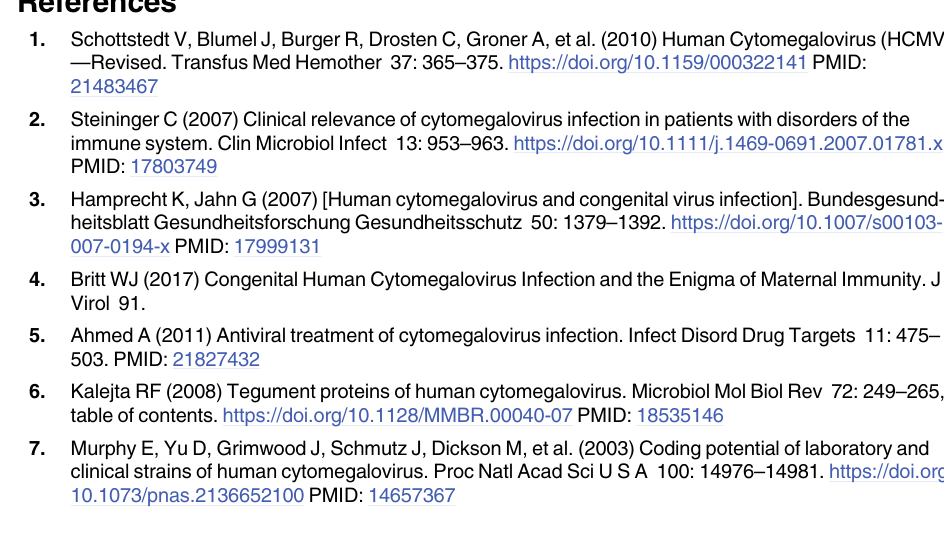
S1 Table. Target host sequences for sgRNA and